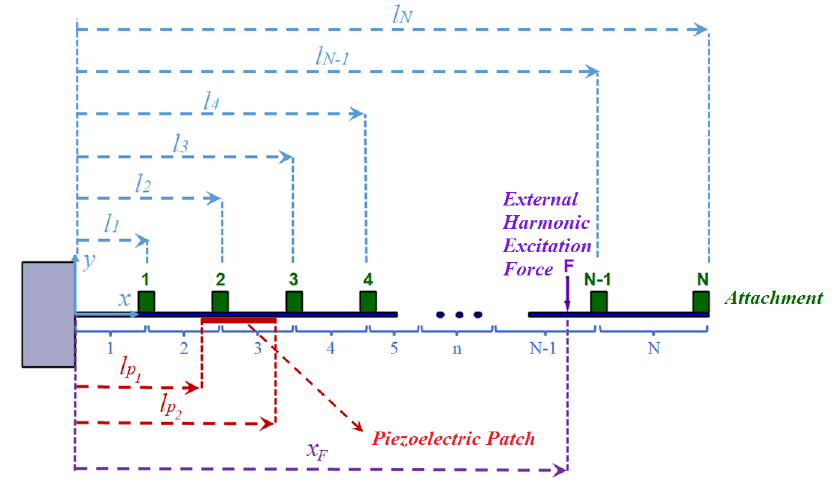
Figure 1. Cantilever beam with several in-span attachments under external harmonic